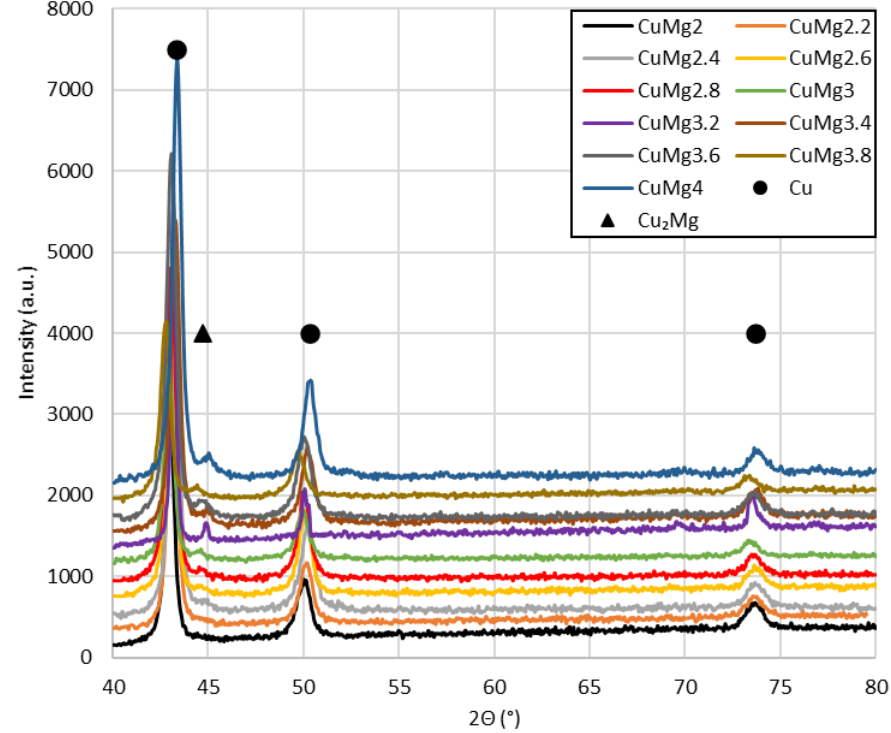
Figure 6. The X-ray diffraction patterns for the CuMg ingots obtained with preliminary alloy CuMg50 in the as-cast state with the marked peaks.